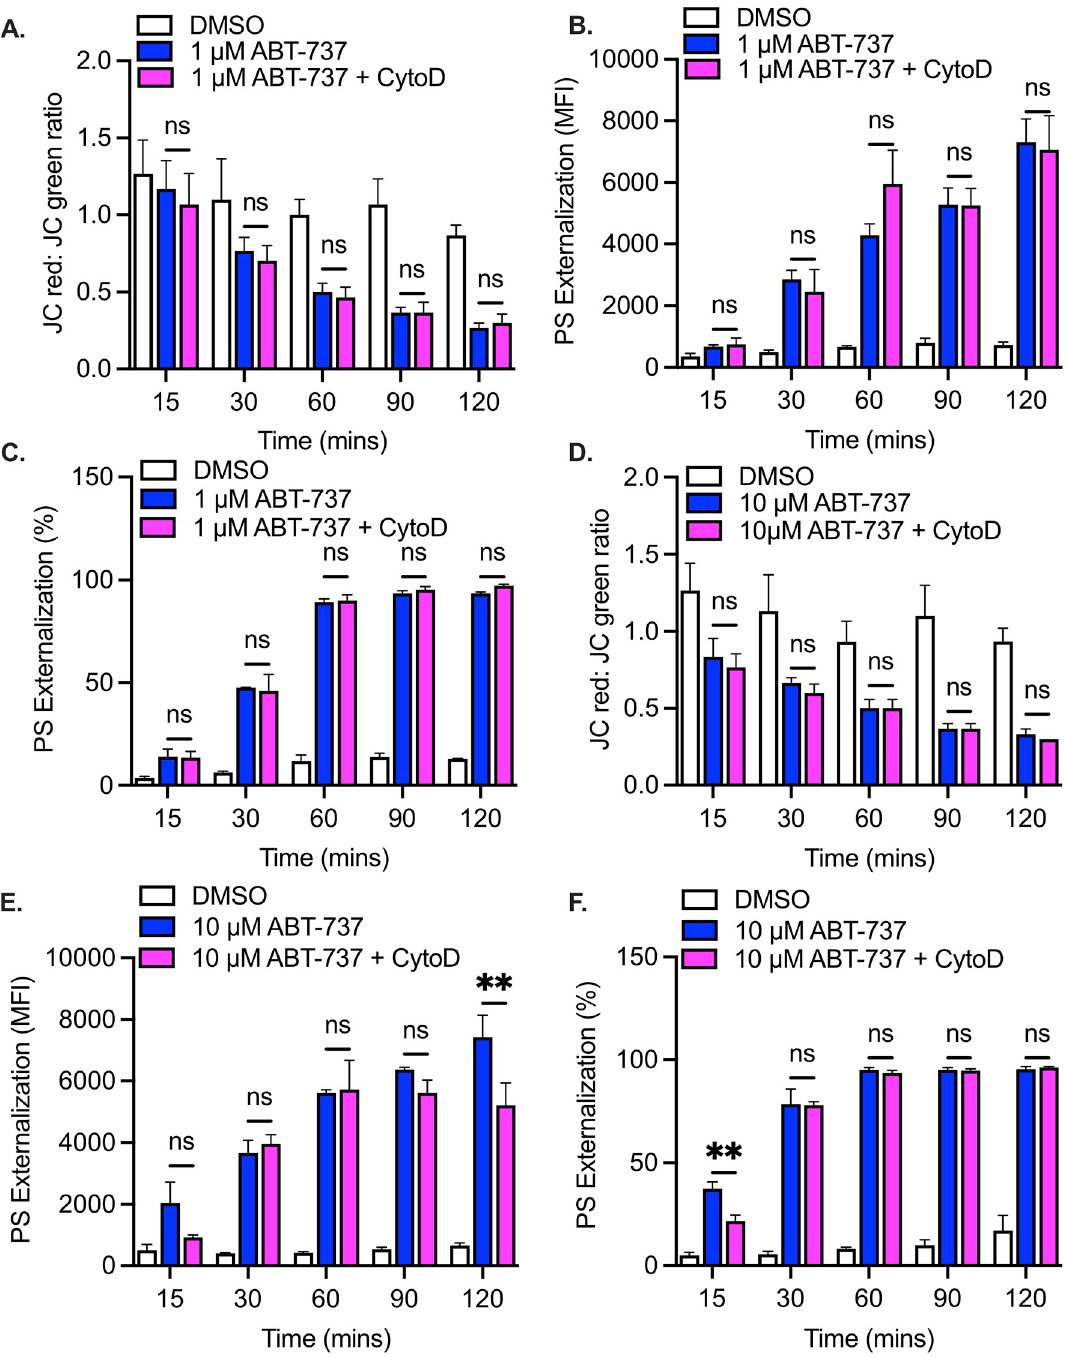
Fig 2. ABT-737-induced mitochondrial depolarization and PS externalization in human platelets are not affected by actin depolymerization. A . Mitochondrial depolarization was measured in washed human platelets using the JC-1 dye. Bar graph depicts the loss of mitochondrial membrane potential in platelets treated with DMSO vehicle alone (DMSO, white bars), with 1 μ M ABT-737 (ABT-737, blue bars) or with 1 μ M ABT plus the actin depolymerizing agent cytochalasin D (ABT-737+CytoD, pink bars). Data are mean ± SEM, analyzed by 2-way ANOVA and Bonferroni post-hoc multiple comparison tests, and represent a minimum of 3 independent experiments using blood from different donors. B, C . Phosphatidylserine (PS) exposure was measured in washed platelets using the Annexin V dye. Bar graphs depict PS exposure in platelets treated with DMSO vehicle alone (DMSO, white bars), with 1 μ M ABT-737 (ABT-737, blue bars) or with 1 μ M ABT plus the actin depolymerizing agent cytochalasin D (ABT-737+CytoD, pink bars). Data are expressed both in terms of mean fluorescence intensity (B) and as a percentage (%) of PS-positive platelets (C) . Data are